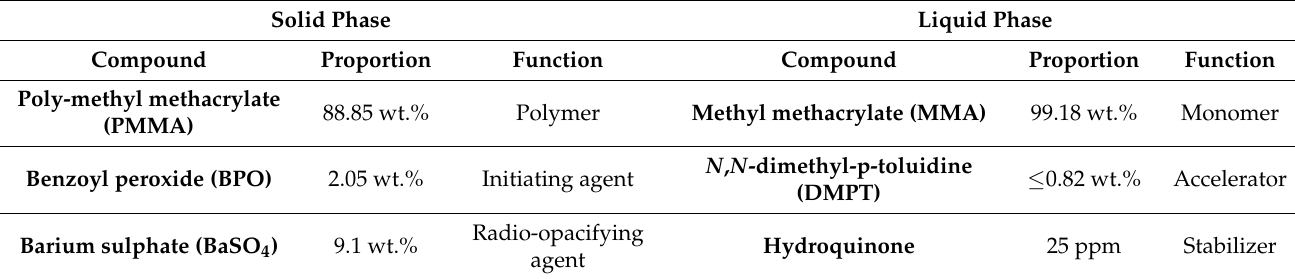
Table 1. Composition of DePuy Ib é rica CMW 1 bone cement radio-opaque.